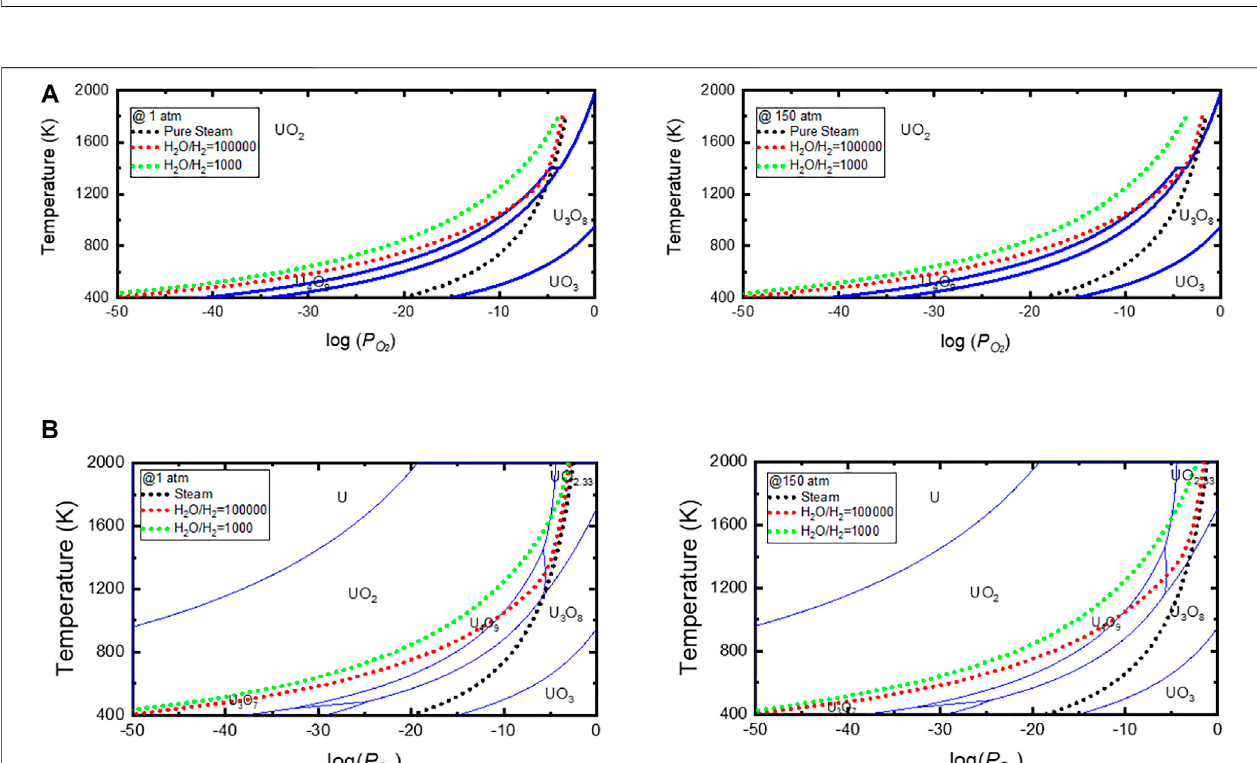
FIGURE 4 | U – O stability diagram and equilibrium oxygen potentials of steam and steam – hydrogen mixed gas. U – O stability boundary is constructed using (A) thermodynamic equations in Ref. (Kim, 2000), and (A) Tpp module in HSC9 Chemistry (HSC Chemistry 9, 2018).